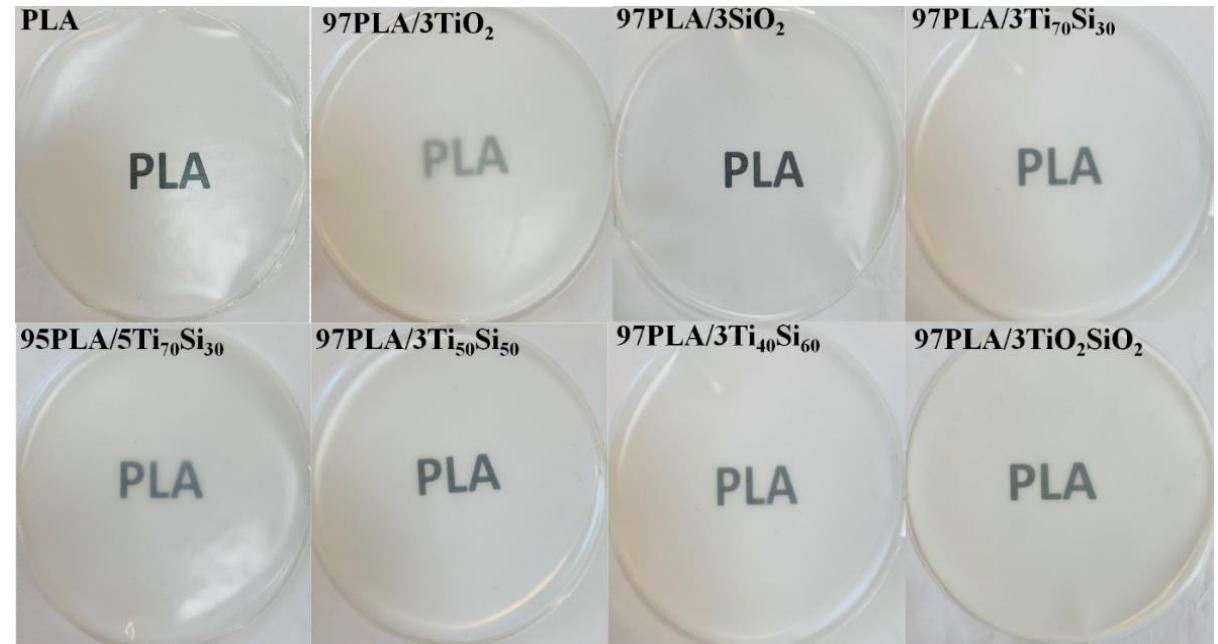
Figure 9. Photographs of films prepared from PLA, PLA/TiO 2 , PLA/SiO 2 , PLA/Ti x Si y , and PLA/TiO 2 SiO 2 composites (250 ± 4.68 µm thickness).